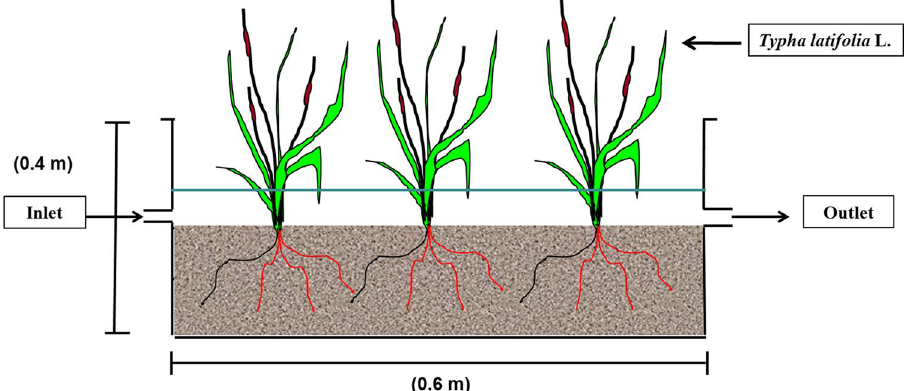
Fig. 1 Schematic setup of constructed microcosm for Fe removal using T. latifolia